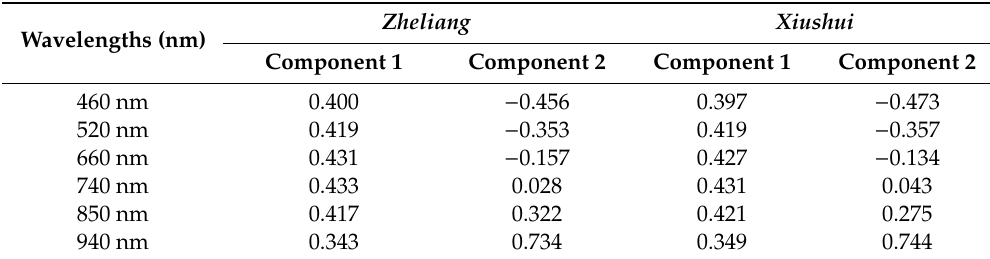
Table 1. Contribution of changes in the reflectance at six wavelengths into total variation of principal components in rice seeds of Zheliang and